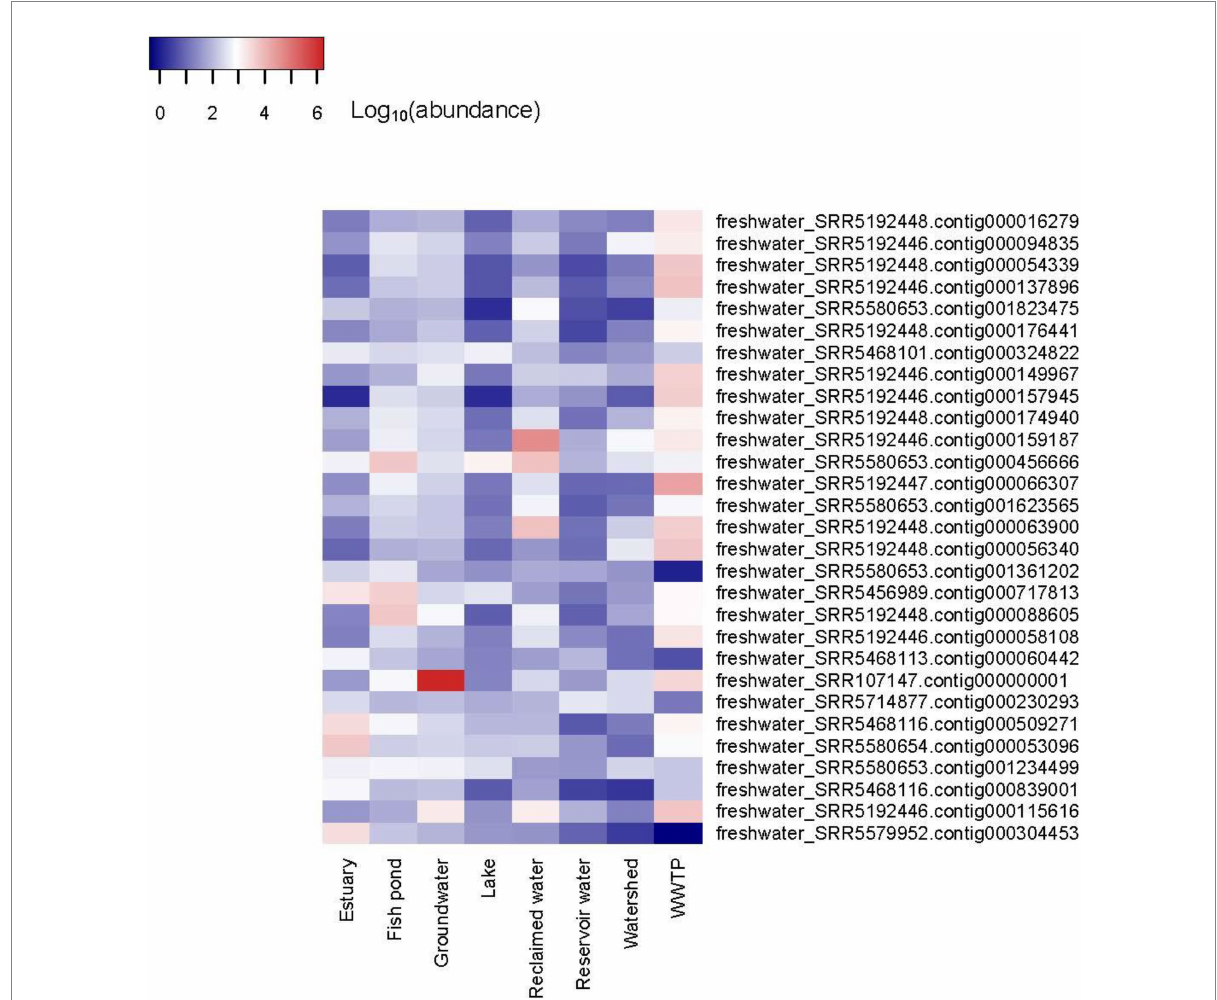
FIGURE 3 Heatmap of the abundance of 29 contigs with nonzero abundance among all studied biomes. The heatmap was generated using Heatmap3 R package v.1.1.7 (Zhao et al., 2014) in R v.4.0.2 (R Development Core Team, 2020) after log 10 transformation of abundance values for better